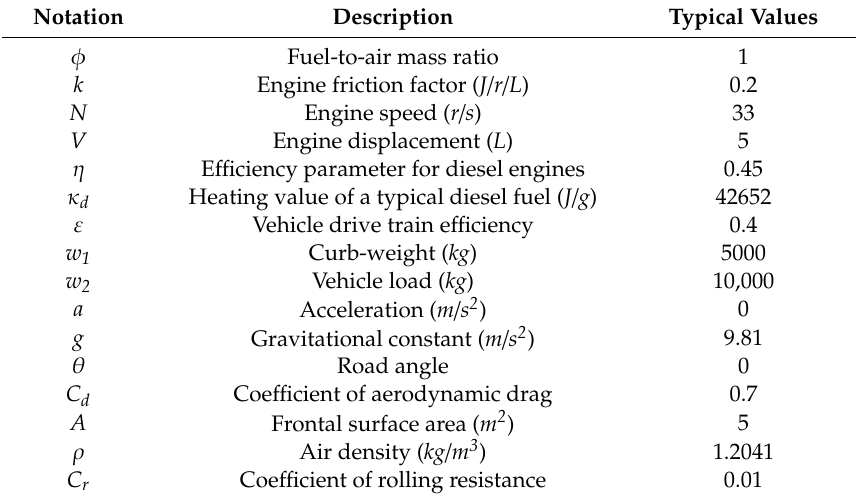
Table 6. Relevant parameters for vehicle fuel consumption